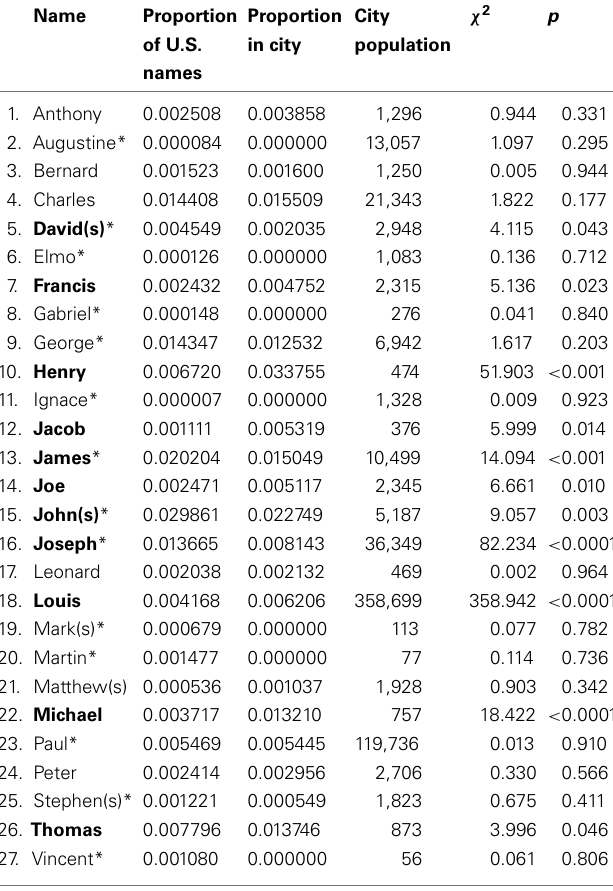
Table 1 |The Saint cities data set from Pelham et al., 2002,Table 8; male Saint names